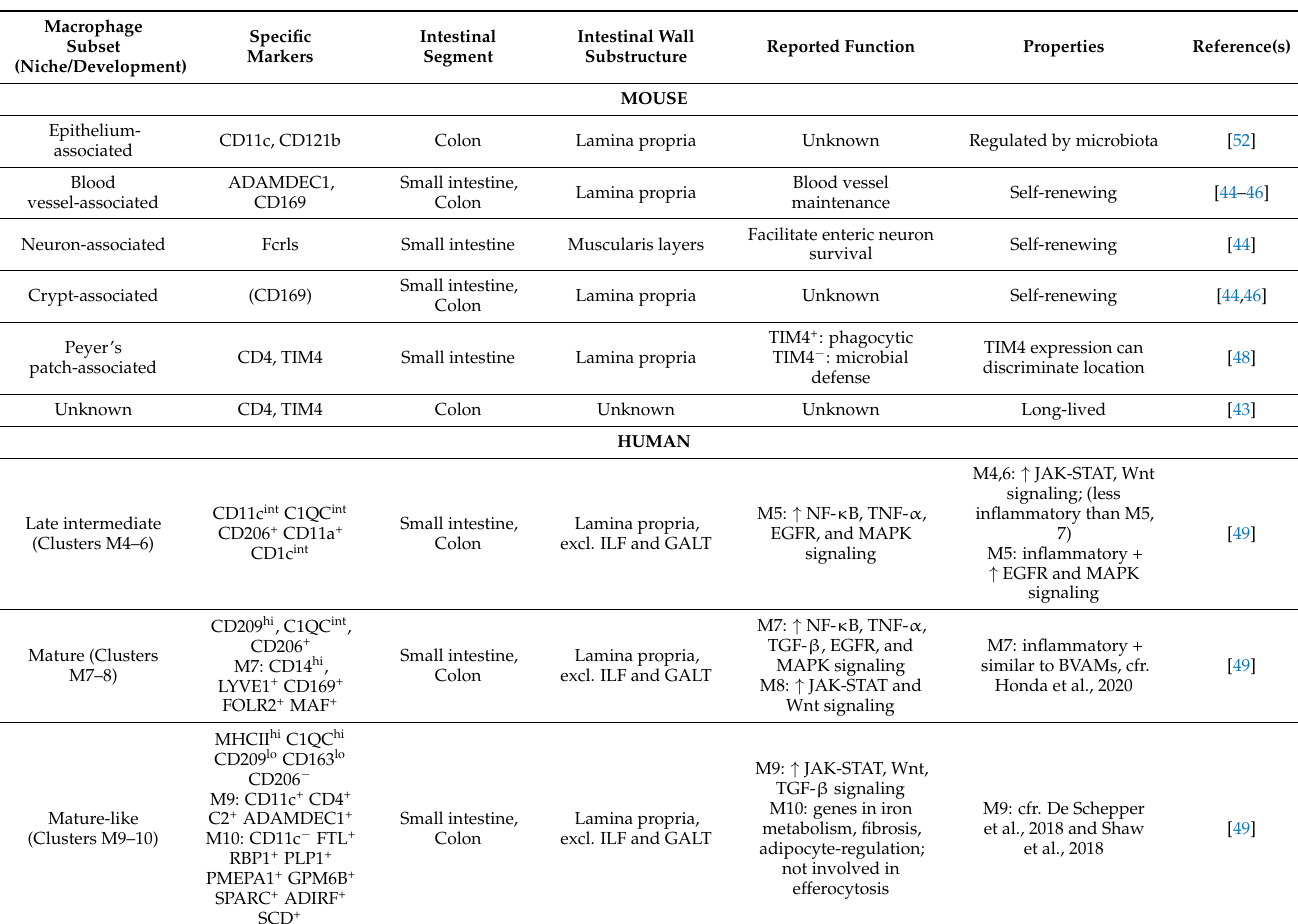
Table 1. Intestinal macrophage subsets in mouse and